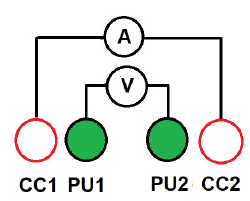
Figure 4. Schematic of a four electrode configuration set up. CC1 and CC2 are the current carrying electrodes while PU1 and PU2 are the voltage pick up electrodes.